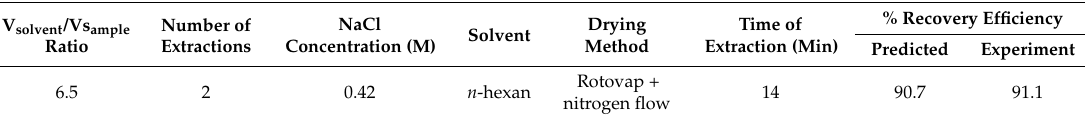
Table 3. Optimization of phthalate extraction